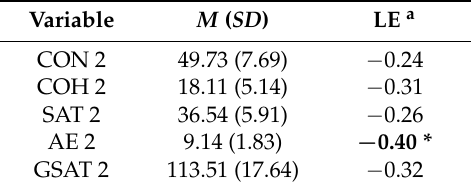
Table 5. Correlation coefficients for the general relationship of satisfaction with the relationship and its components to life events in the second round of the